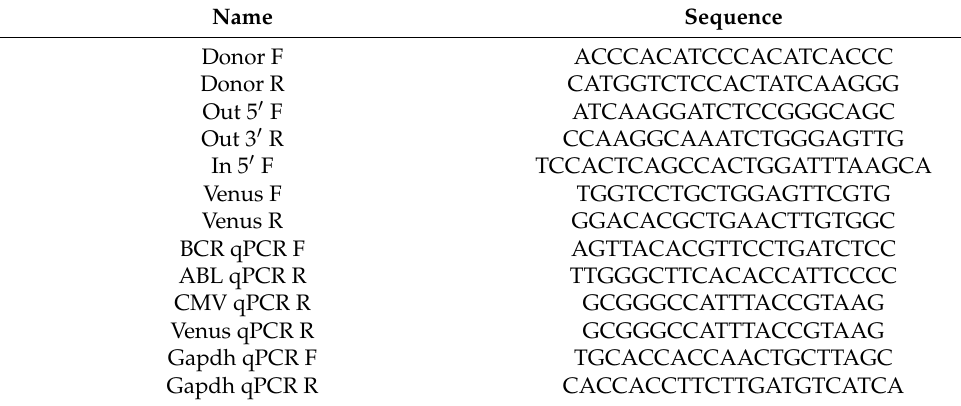
Table 1. Oligonucleotides